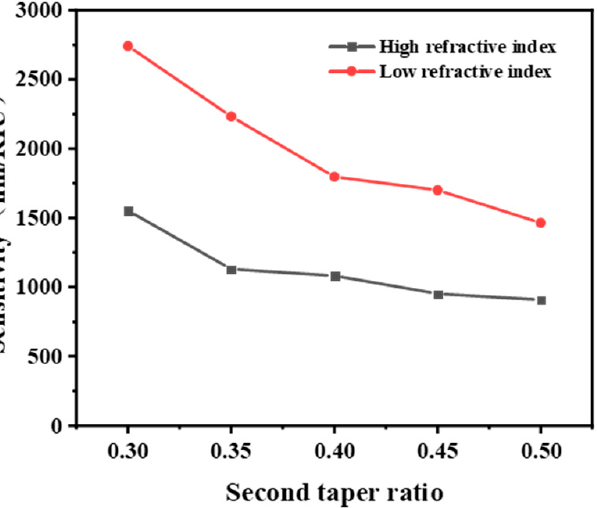
Figure 4. Influence of the second taper ratio on sensitivity performance of the taper-in-taper fiber sensor.